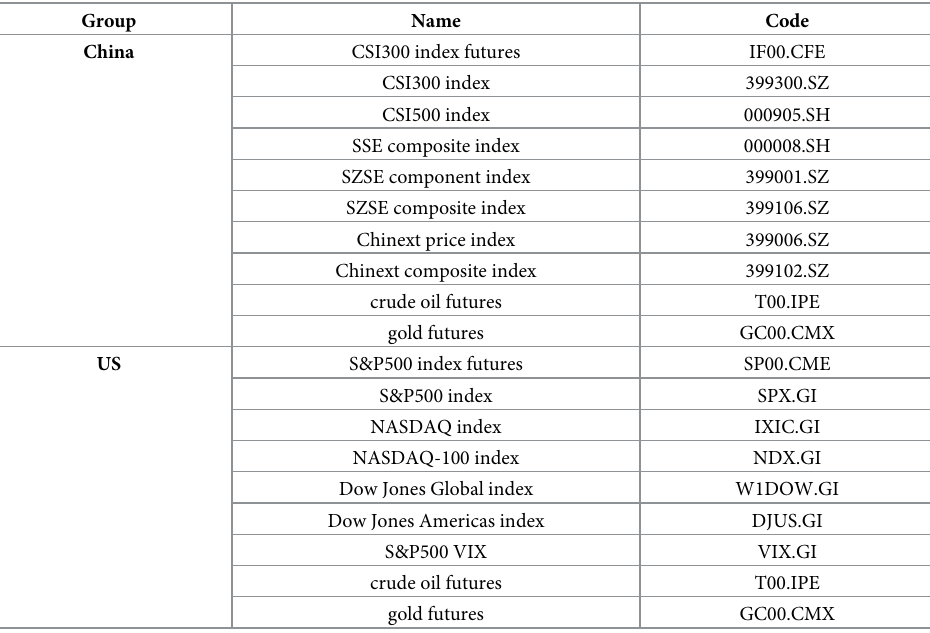
Table 1. Summary of the datasets in China and the US.